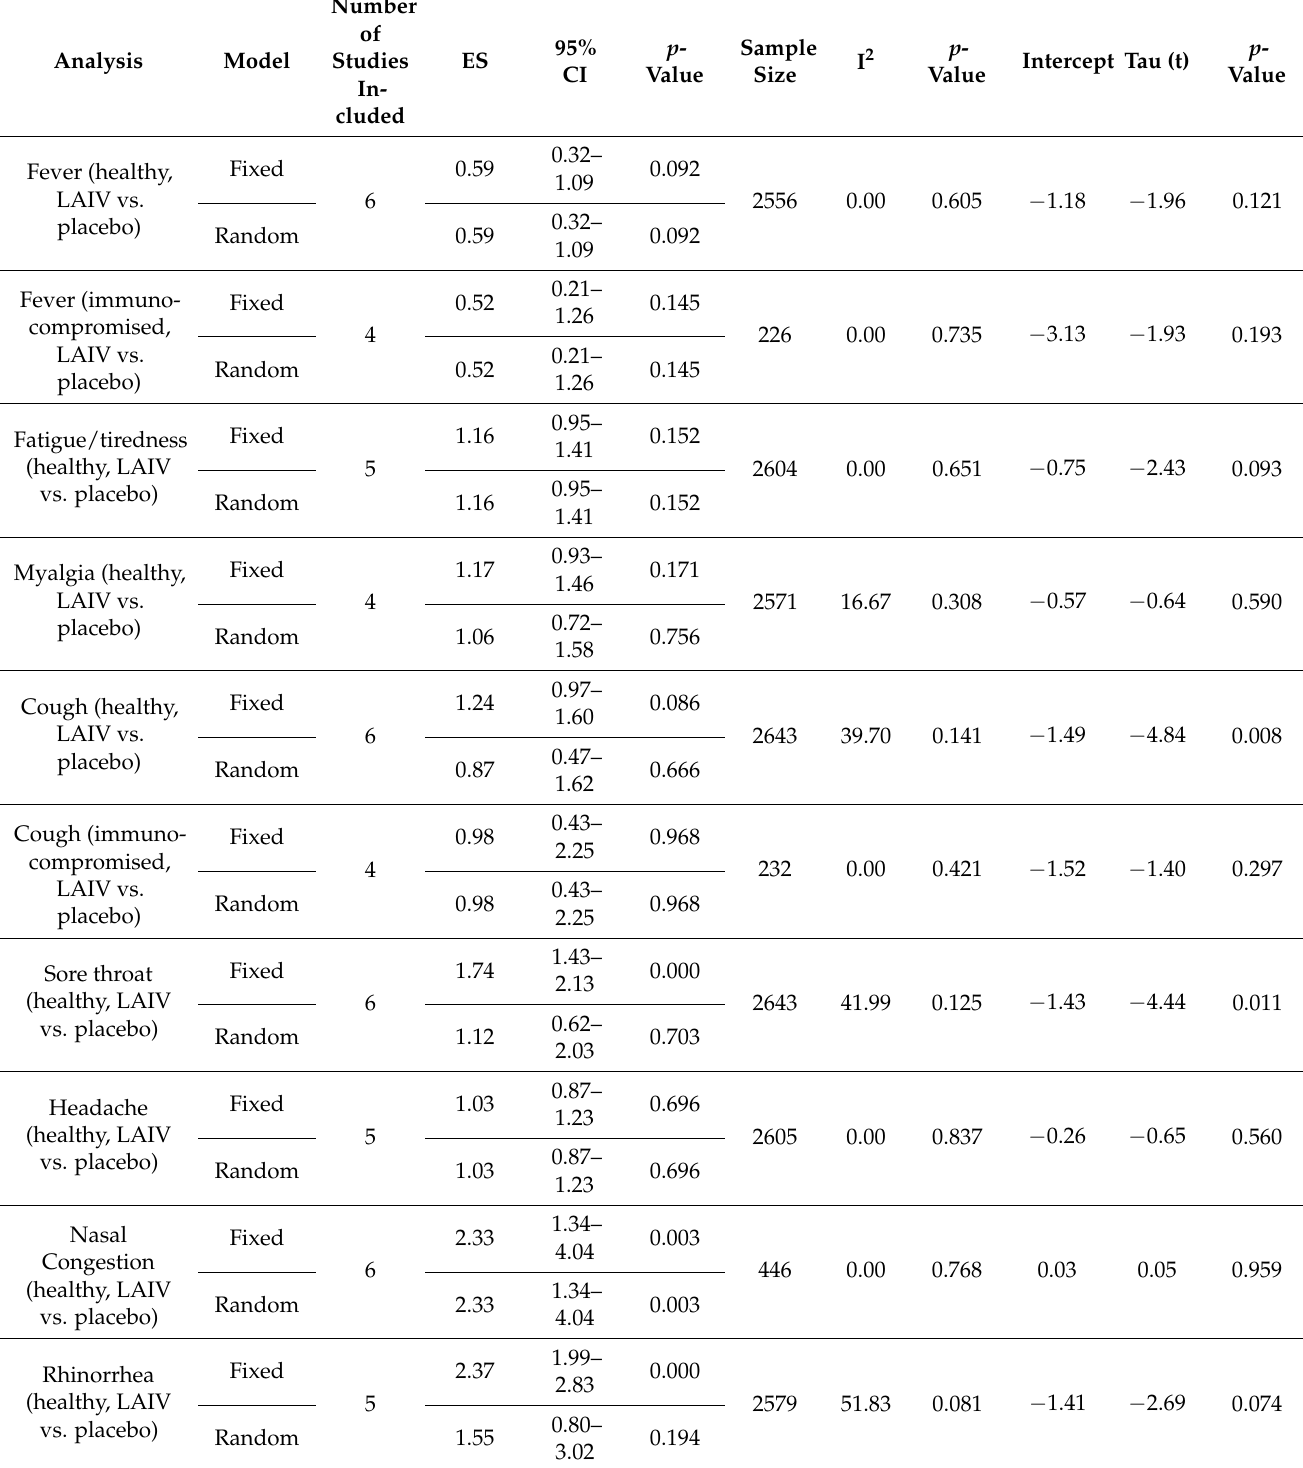
Table 3. Meta-analyses assessing LAIV safety among healthy and immunocompromised subjects stratified by adverse events following immunisation (AEFI). ES: effect size, reported as odds